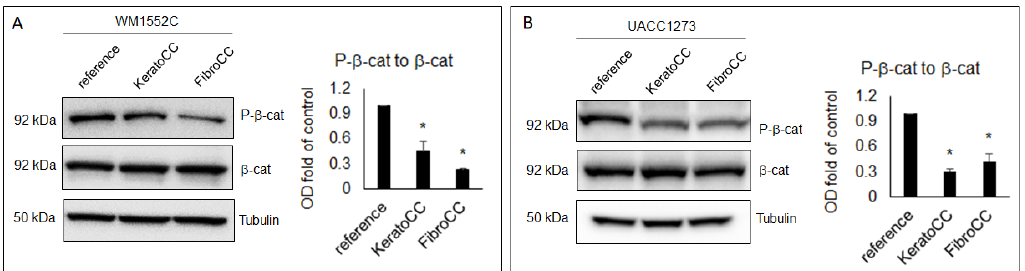
Figure 4. Poorly aggressive melanoma cells show increased Wnt activity after exposure to normal skin cells. Results from WB and densitometric analysis of WB bands show decreases in the ratio of P- β -catenin to total β -catenin (P- β -cat to β -cat), indicating reduced degradation of β -cat, which would lead to increased potential for Wnt signaling in WM1552C ( A ) and UACC1273 ( B ) co-cultured with normal human epidermal keratinocytes (KeraCC) and normal dermal fibroblasts (FibroCC) compared to reference cells (* p < 0.05). Results are representative of at least two independent experiments, each performed in triplicate.